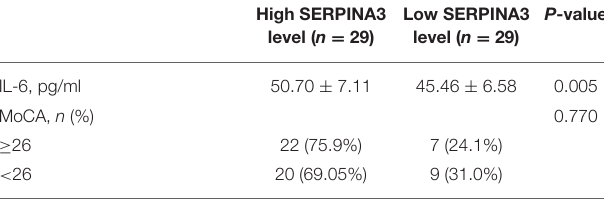
TABLE 1 | Correlation between basic clinical information, laboratory tests, and SERPINA3 levels in the plasma of patients recruited for the study.